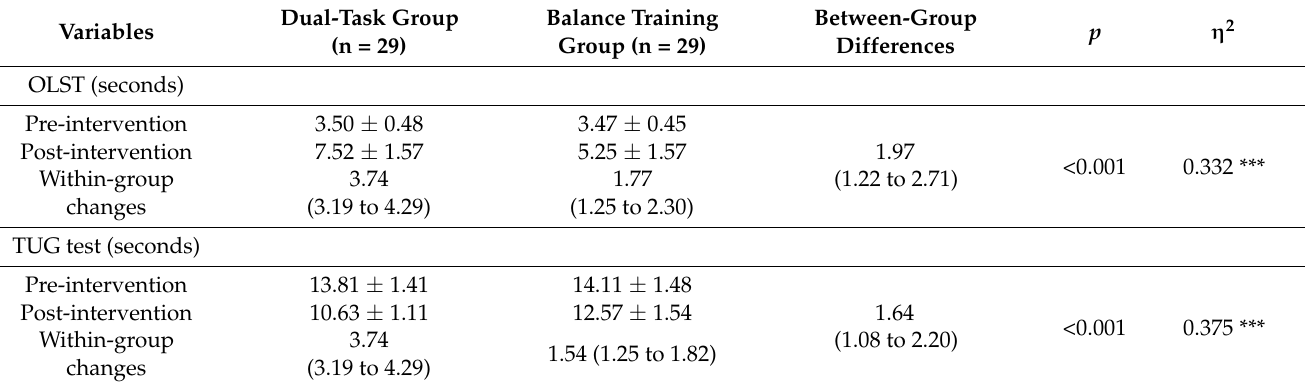
Table 4. Changes in static and dynamic balance (N = 58).